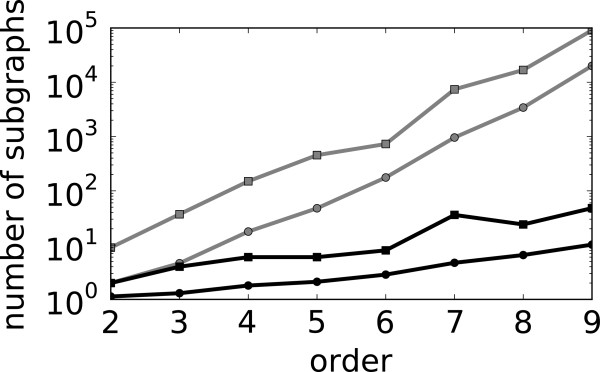
Subgraph enumeration for double-layer MAPK mechanism. Number of subgraph candidates generated for 100 randomly selected fragments (of indicated order) of the double-layer MAPK network. Gray: combinatorial approach, black: using the path and cycle graphs. Circles denote averages, squares denote maxima (maximal number of subgraph candidates generated for any one of 100 randomly selected fragments).